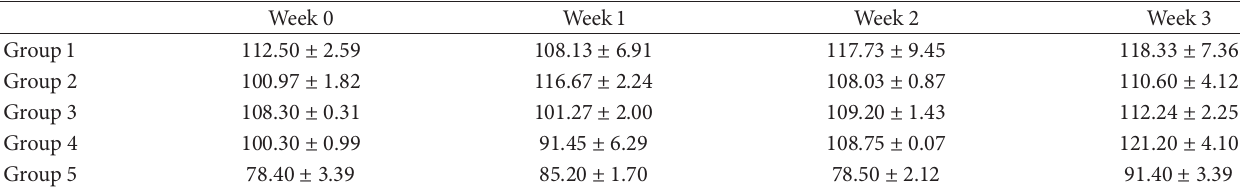
Table 5: Feed intake of rats (g/week).